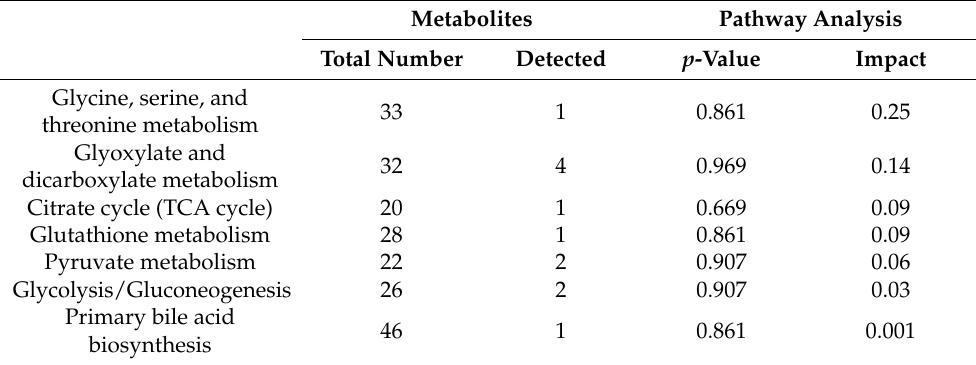
Table 3. Results of pathway analysis with MetaboAnalyst 5.0 (https://www.metaboanalyst.ca) indicating the total number of involved metabolites and those detected in our data based on the p -value and the impact of each metabolic pathway. Analysis performed on 20 July